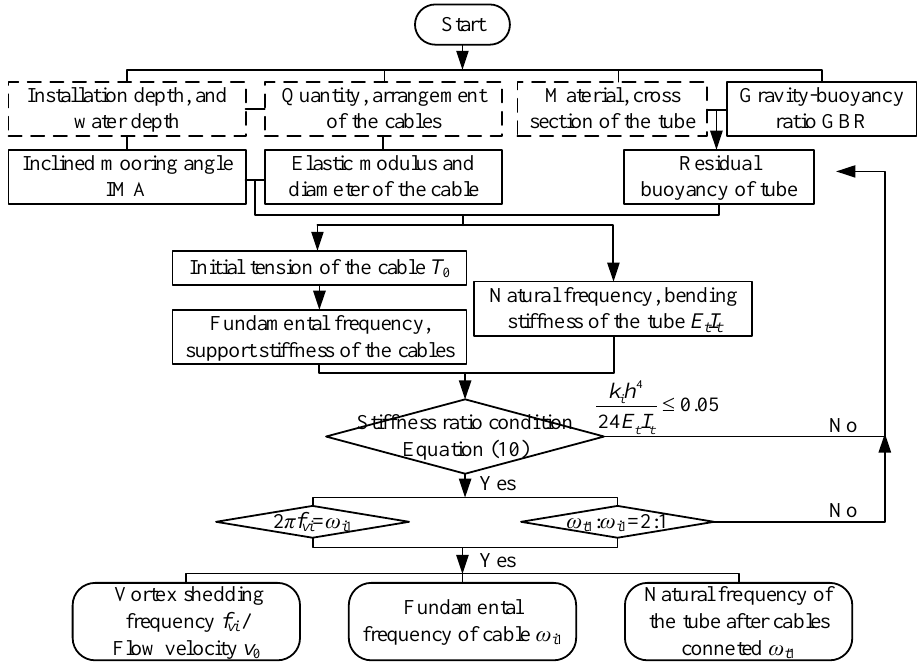
Figure 2. Flow chart for determining the parameters of SFT in case study.